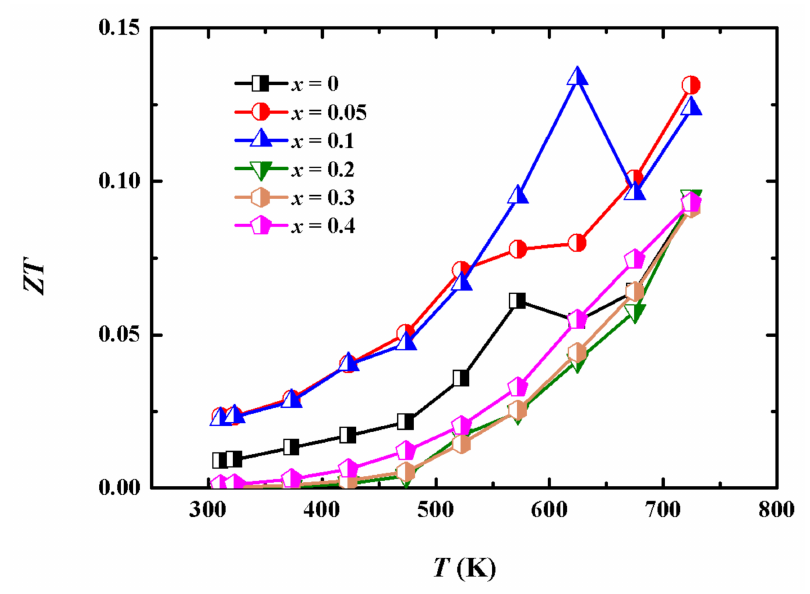
Figure 6. ZT of (Cu 2 Te) 1 − x -(BiCuTeO) x as a function of temperature.